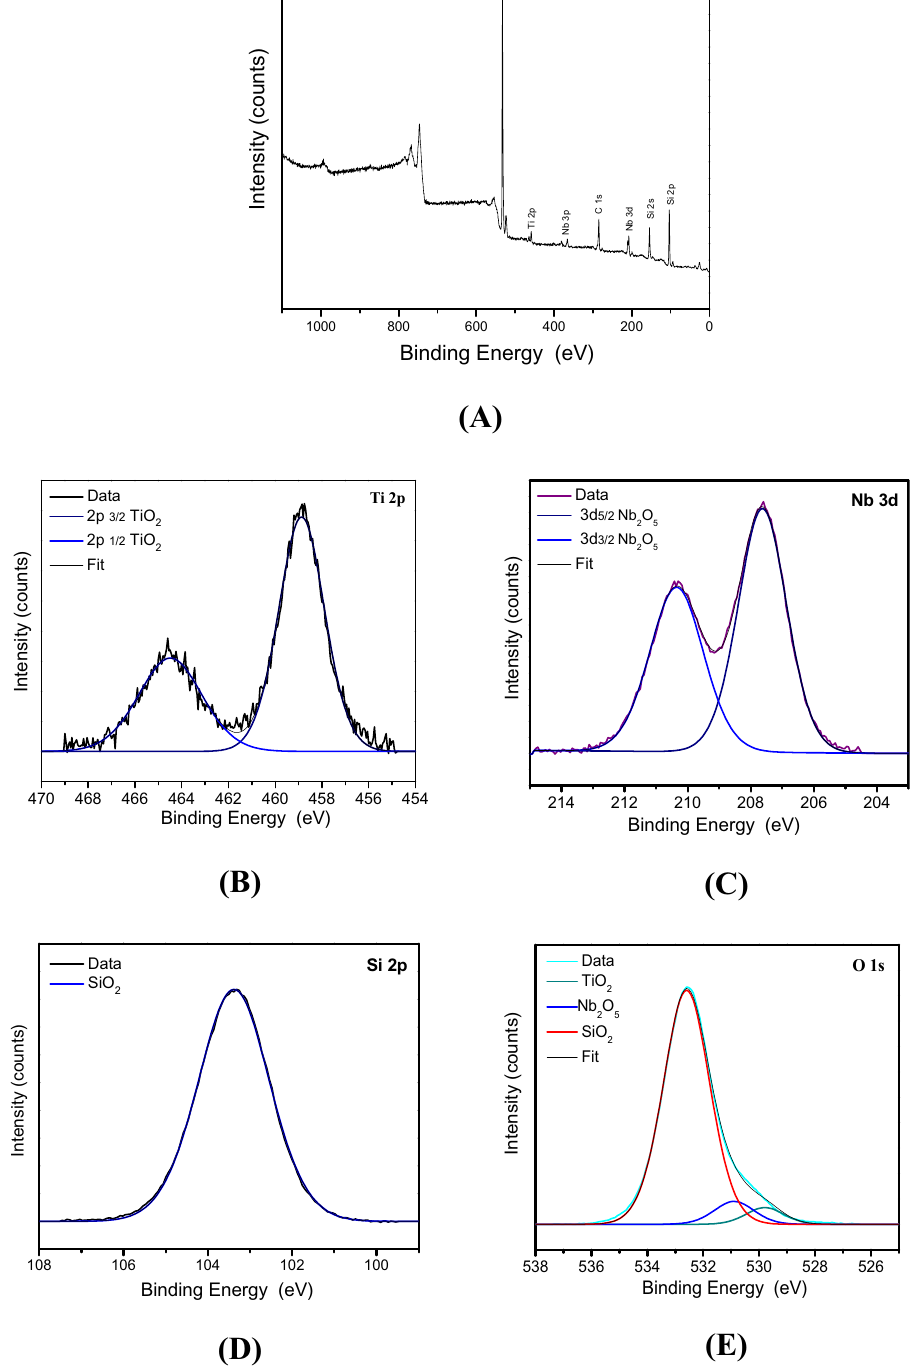
Figure 7. XPS analysis of SiTiNb-B material. Survey Spectrum (A) and the higher resolution spectra in the regions of Ti 2p (B) , Nb 3d (C) , Si 2p (D) e O 1 s (E)